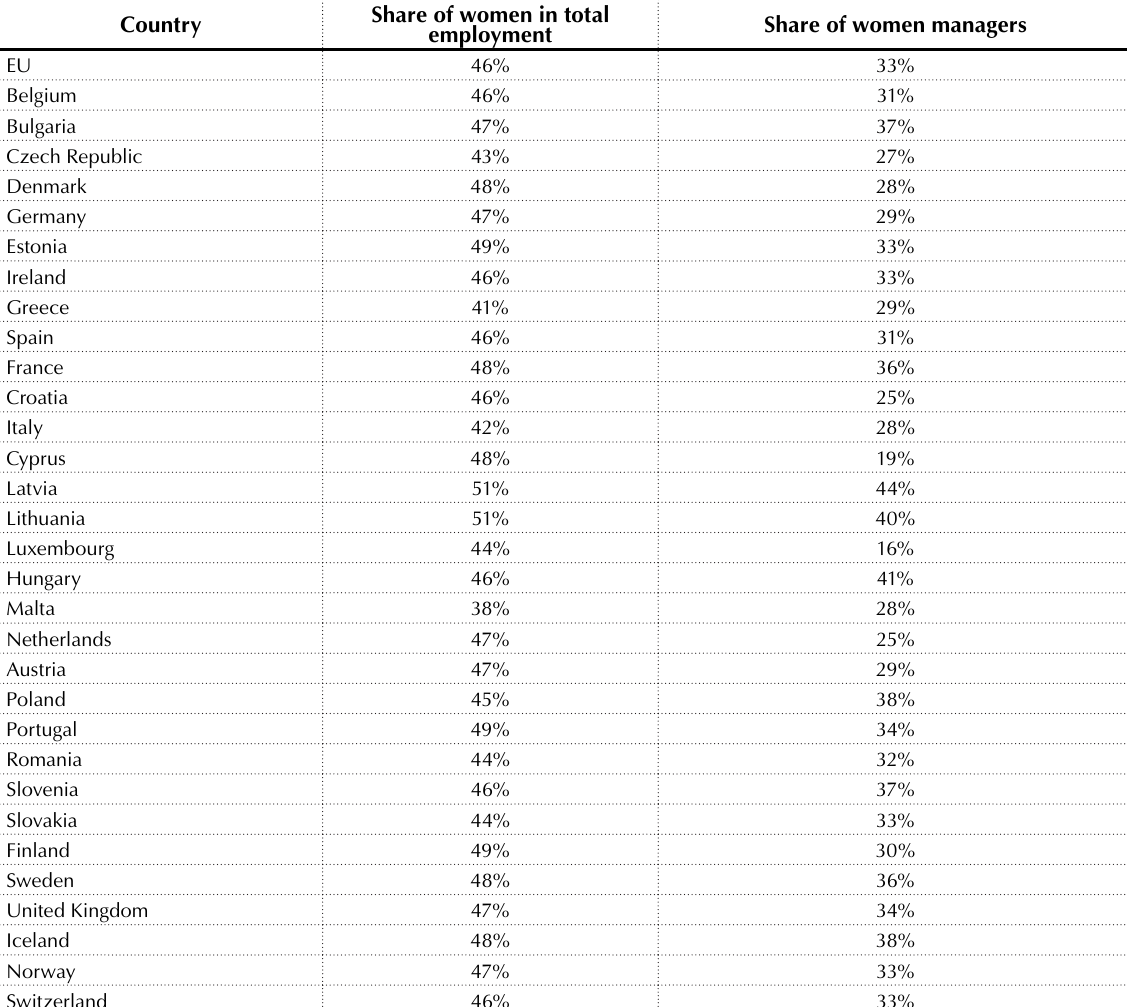
Source: elaborated by authors according to Eurostat (2013).